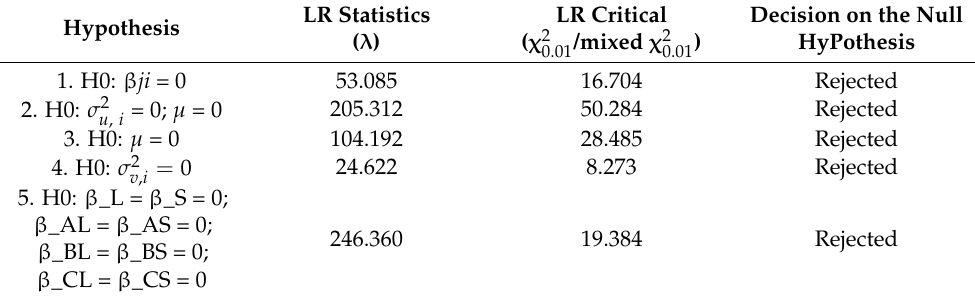
Table 2. Hypotheses test